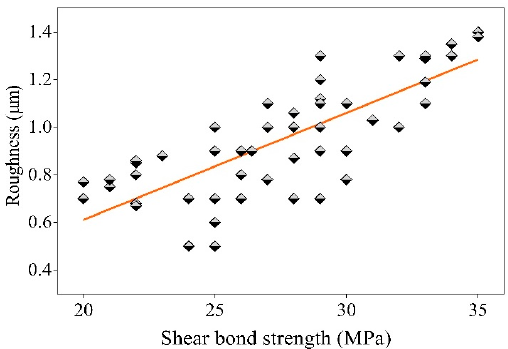
Figure 10. Dot plot illustrating significant correlation ( r ) between SBS and R a values ( r = + 0.7855, p < 0.05). Su ffi cient bond strength values in specimens may have resulted from the existence of higher R a values. The fracture mode patterns for the specimens in unaged and aged conditions are presented in